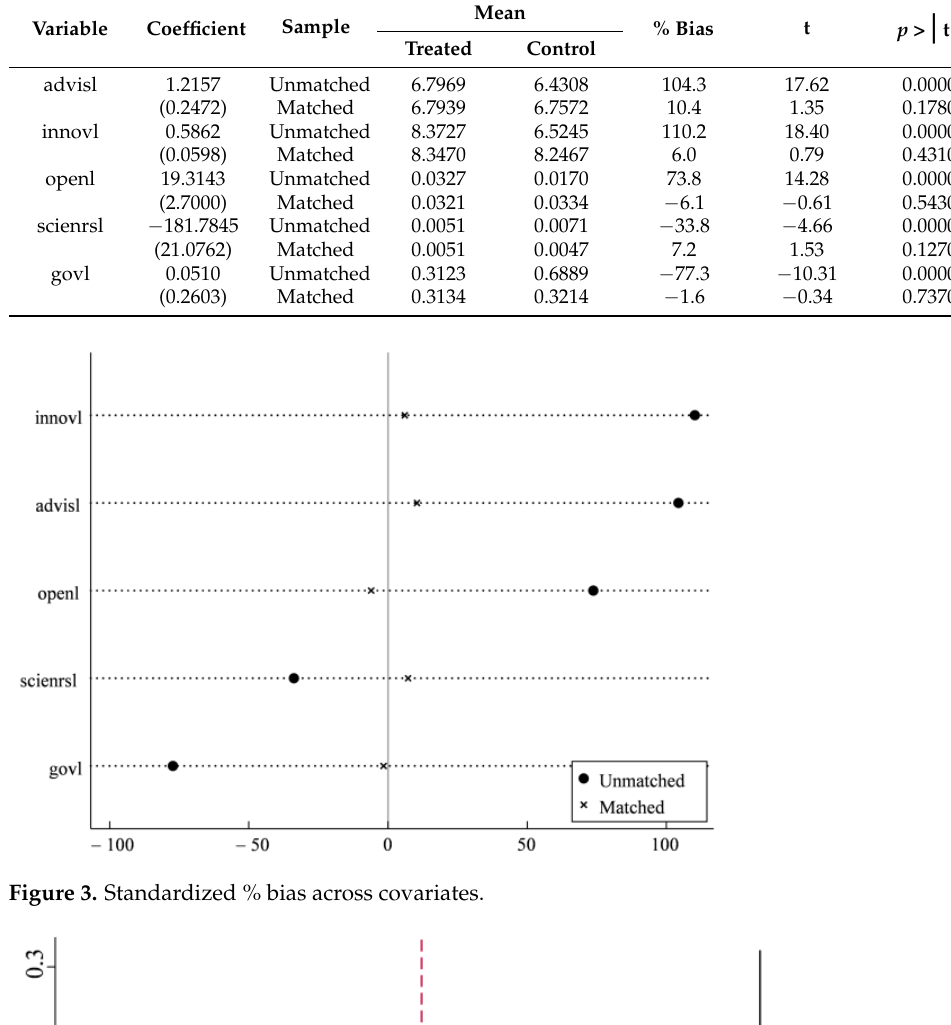
Figure 2. Comparison of propensity score distribution between treatment group and control group before and after PSM. Table 5. PSM and balance test results.